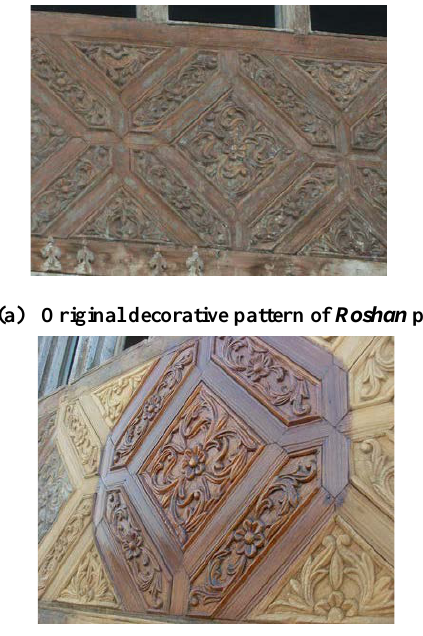
Fig 4. Repairing Rawsheen in Sharbatly building and carful cleaning by using a Piece of cotton wet with